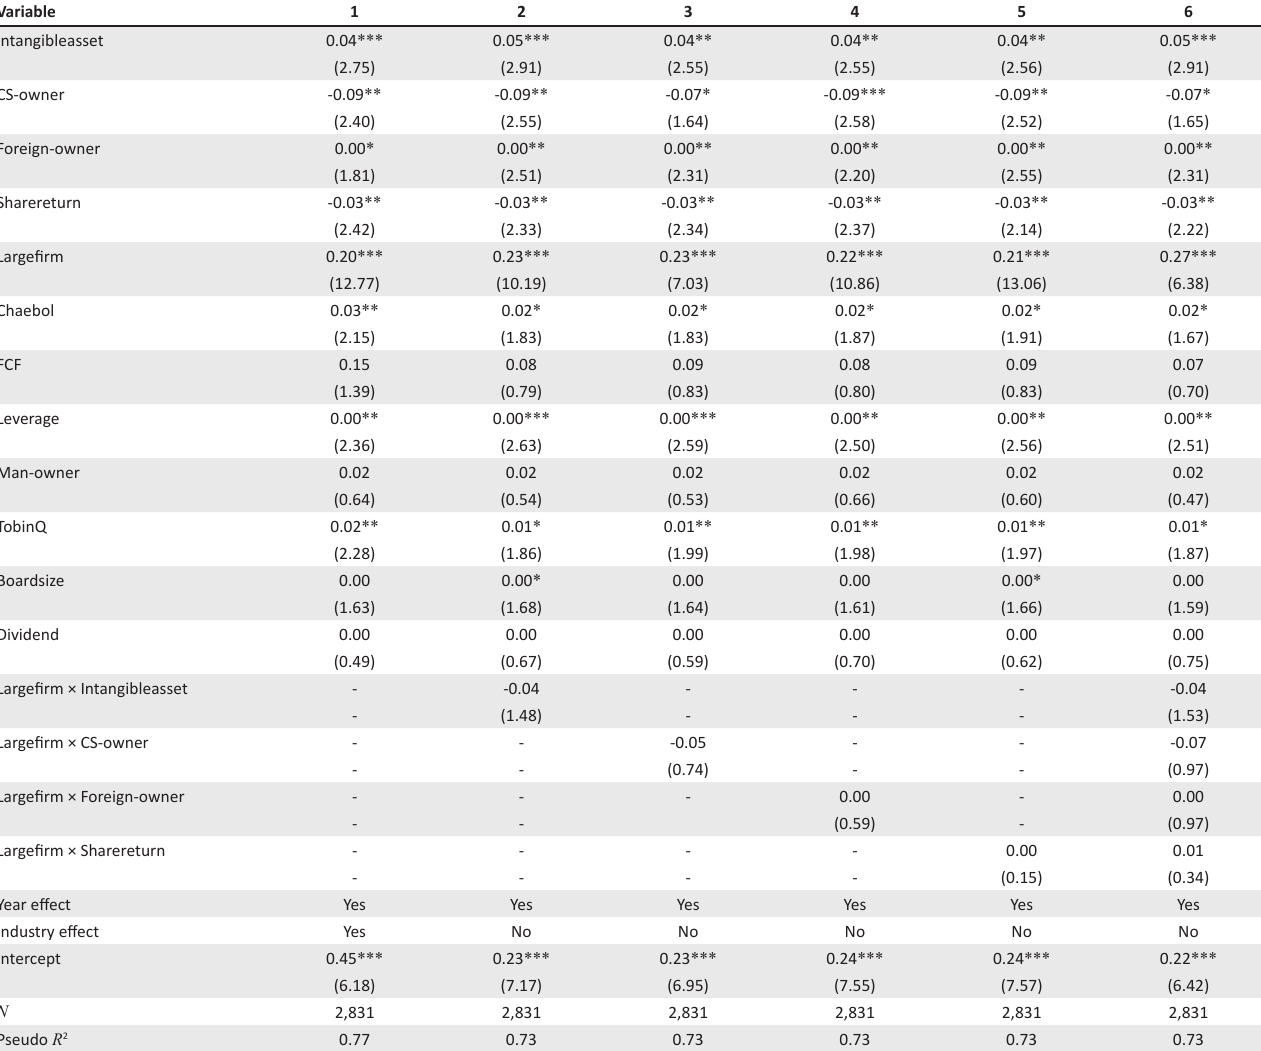
TABLE 4: Estimation of excessive appointment of outside directors: a further restriction for large firms.